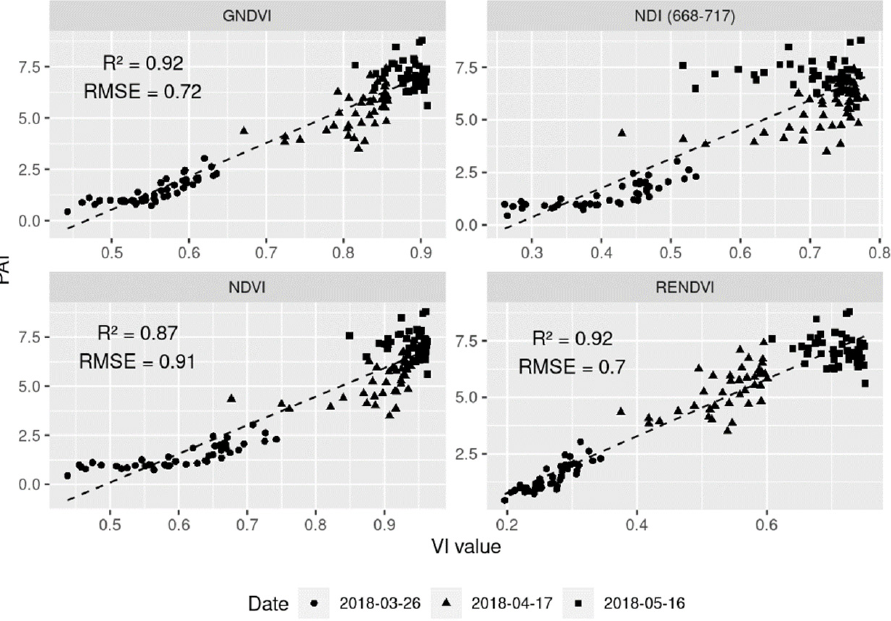
Figure 6. VI values derived from spectral information acquired by MicaSense ® RedEdge-M TM sensor mounted on quadcopter UAV plotted against ground-truth measurements of PAI derived from ground-truth digital hemispherical photography (DHP) during the 2018 winter wheat growing season (end March, mid-April, mid-May) over the studied field. NDI (668-717) = NDI 668-717